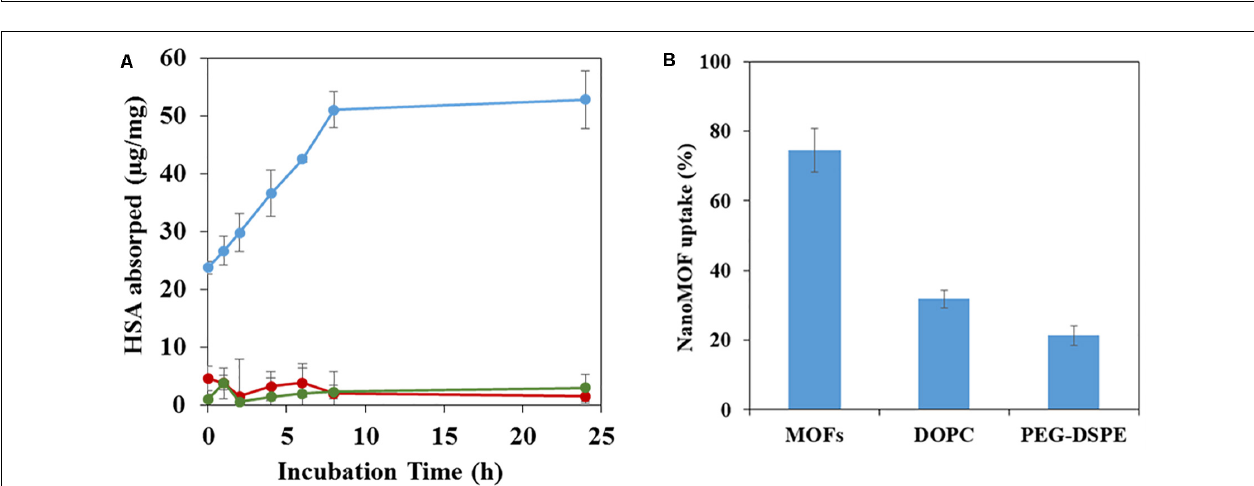
FIGURE 7 | Cytotoxcity measured by MTT assays of nanoMOFs (blue), anticancer efficacy of Gem-MP (brown), Gem-MP loaded nanoMOFs before (gray) and after coating with DOPC (red) or PEG-lipid conjugates (green). The experiments were performed on SKOV3 ovarian cancer cells, at different incubation times, with